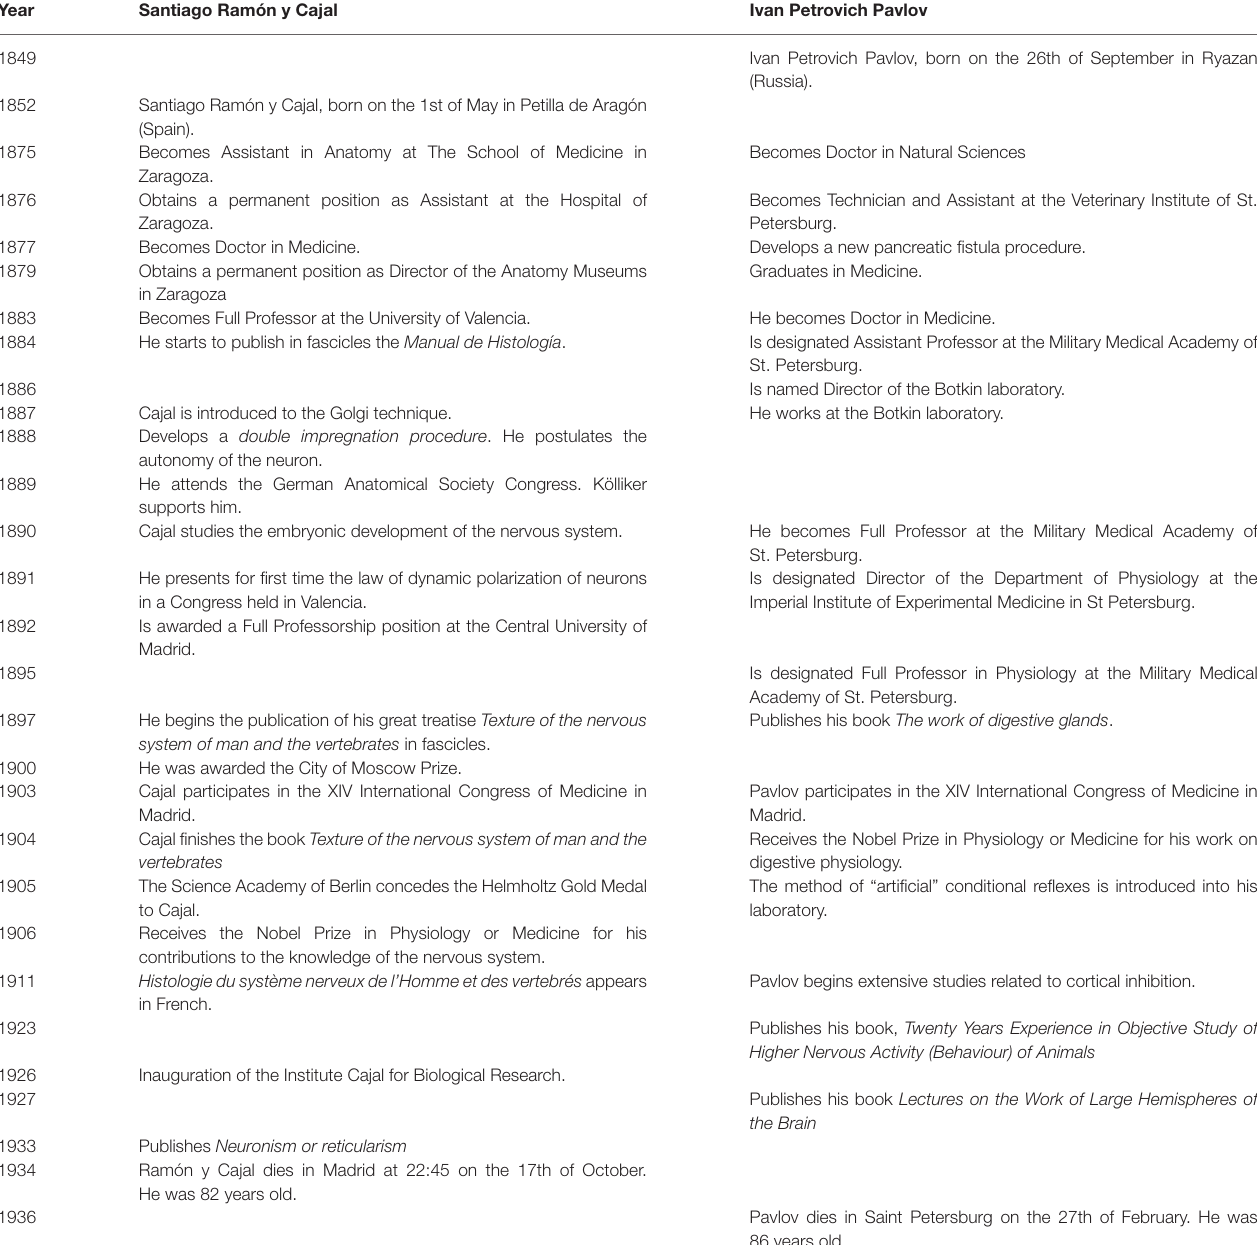
TABLE 1 | The lives of Cajal and Pavlov, their career milestones